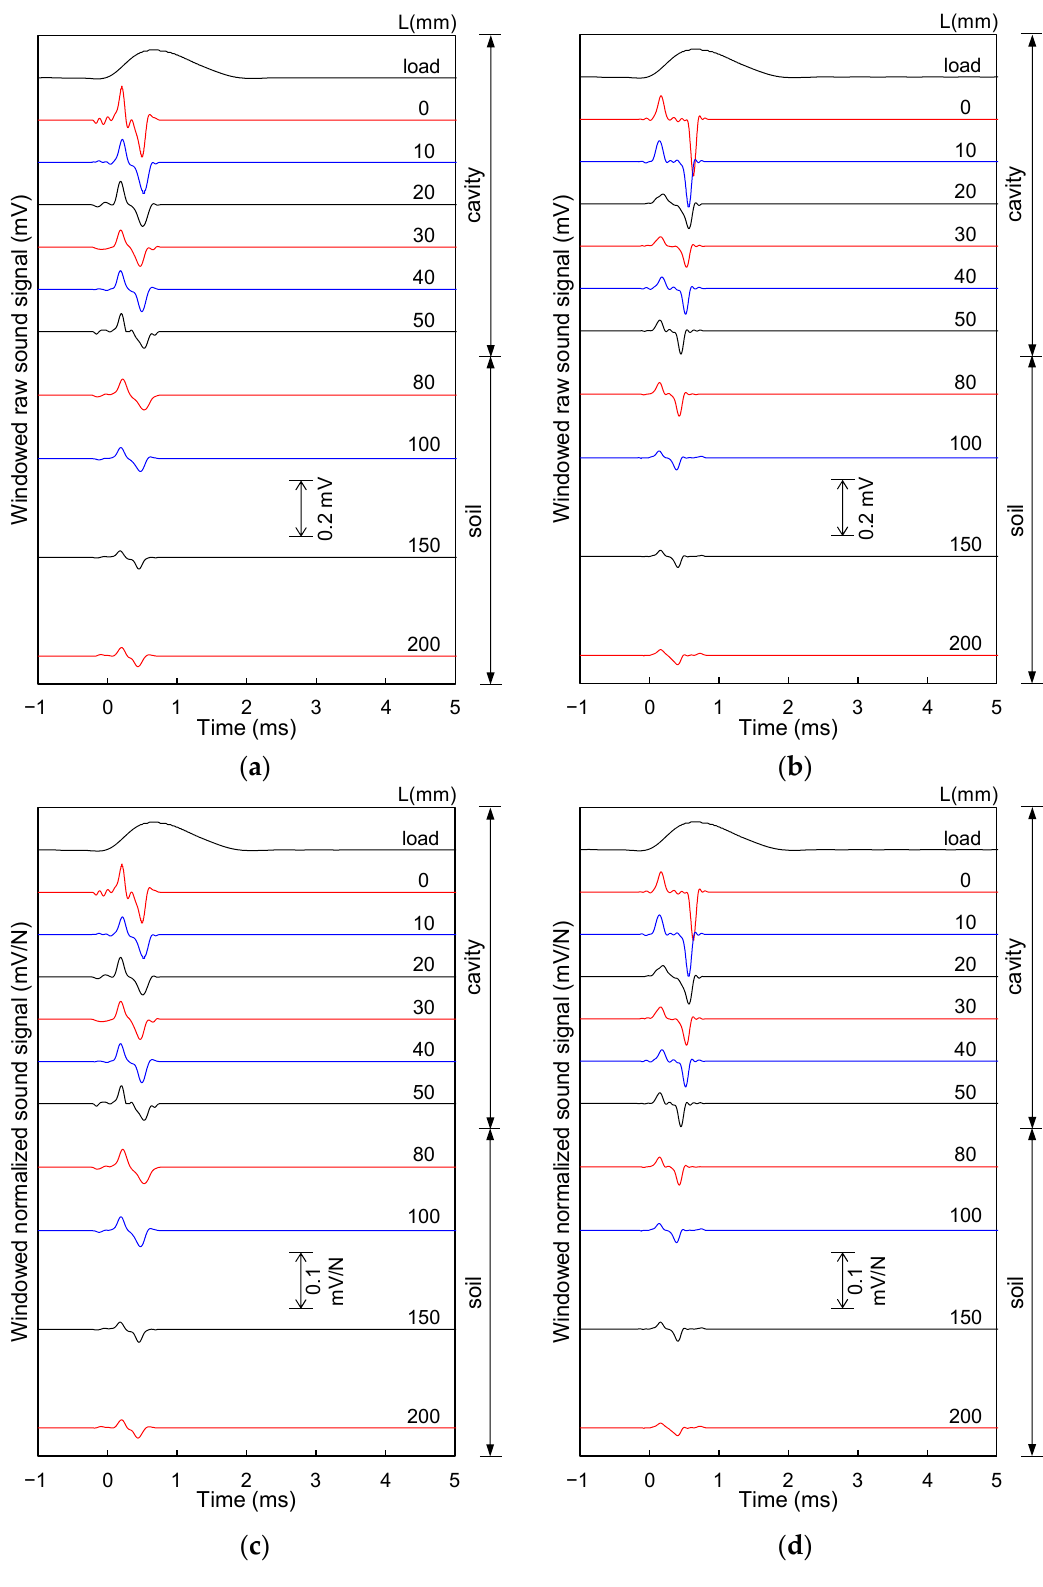
Figure 7. Windowed raw and windowed normalized sound waves according to measurement location: ( a ) windowed raw sound wave for 8 mm thick acrylic plate; ( b ) windowed raw sound wave for 15 mm thick acrylic plate; ( c ) windowed normalized sound wave by hammer impact load for 8 mm thick acrylic plate; and ( d ) windowed normalized sound wave by hammer impact load for 15 mm thick acrylic plate.